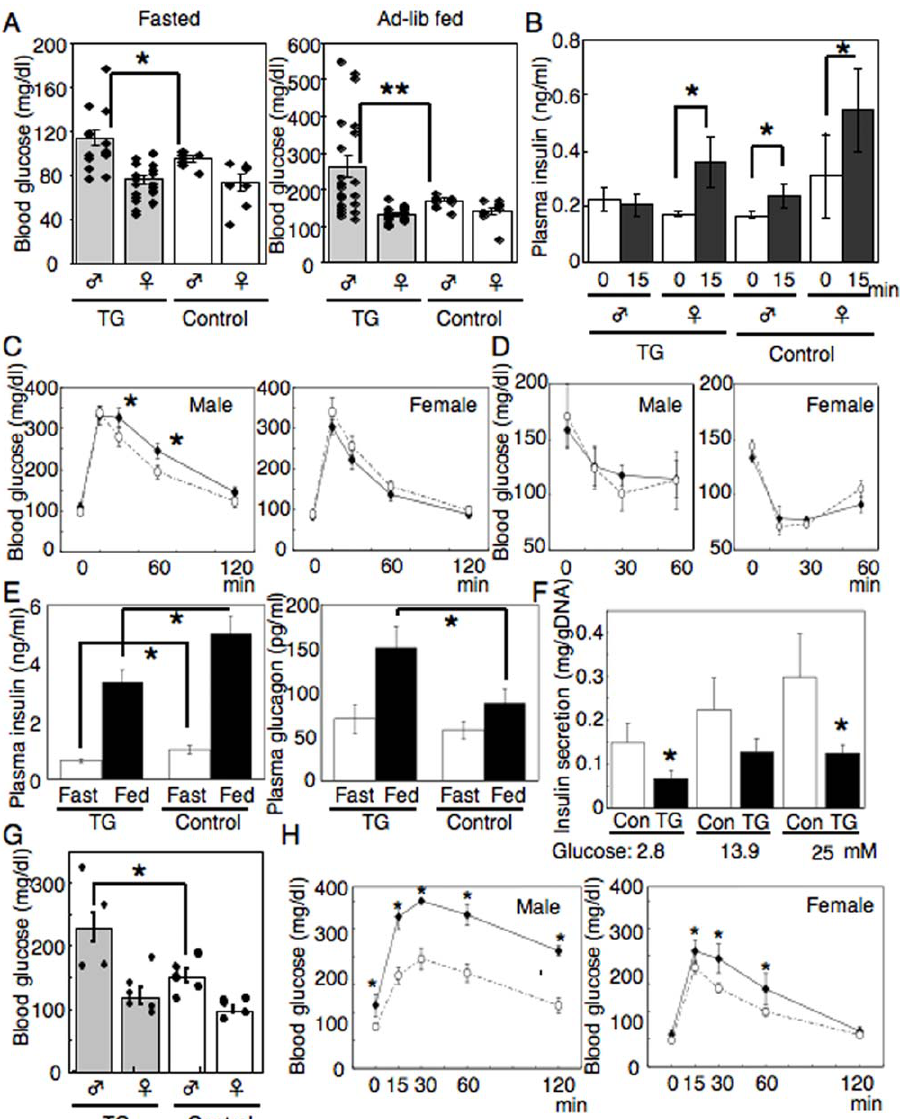
Figure 1. Hyperglycemia and impaired glucose tolerance in TG mice. (A) Blood glucose levels (mg/dl) in fasted and ad-lib fed TG mice and their control littermates at 8 weeks of age. (B) Plasma insulin levels (ng/ml) before and 15 min after glucose (1.2 g/kg) intraperitoneal injection. (C) Intraperitoneal glucose tolerance tests (IPGTT) in male (left) and female (right) TG mice that had normal blood glucose levels in fasted and fed states at 8 weeks of age. (D) Insulin tolerance test (ITT) in male (left) and female (right) TG and control mice at 12 weeks of age. (E) Plasma insulin (left) and glucagon (right) levels in fasted and fed conditions in TG and control mice at 12 weeks of age. (F) The size-matched islets were isolated from male TG and control mice at 12 weeks of age, and glucose-stimulated insulin secretion levels were measured in those islets. The data were normalized by DNA content in those islets (G and H) TG mice that had normal blood glucose levels at 4 weeks of age and their control littermates were fed a HFHSD for 8 weeks further, then, fasted blood glucose levels were measured (G) and IPGTT performed (H) in both male (left) and female (right) mice. In each experiment (A–H), at least six male or female mice for each genotype were analyzed. In the line graphs, closed triangle indicates TG mice and open circle indicates control mice. Data represent mean 6 SEM. * or ** indicates P , 0.05 or P , 0.01 by ANOVA.